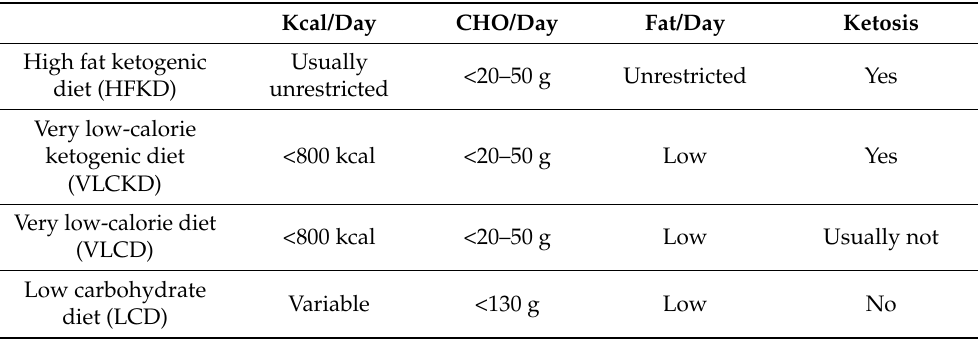
Table 1. Main differences between ketogenic and low-carbohydrate diets (with the kind permission of Watanabe et al.